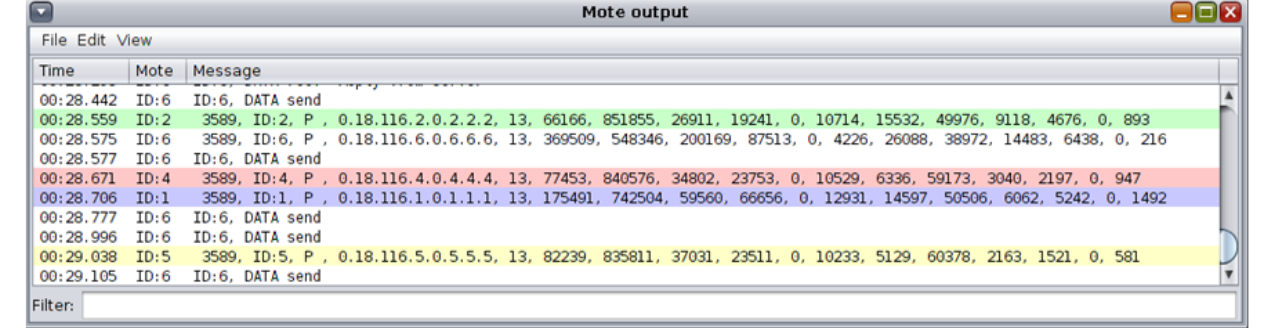
Figure 26. Cooja Simulator — Mote output window.